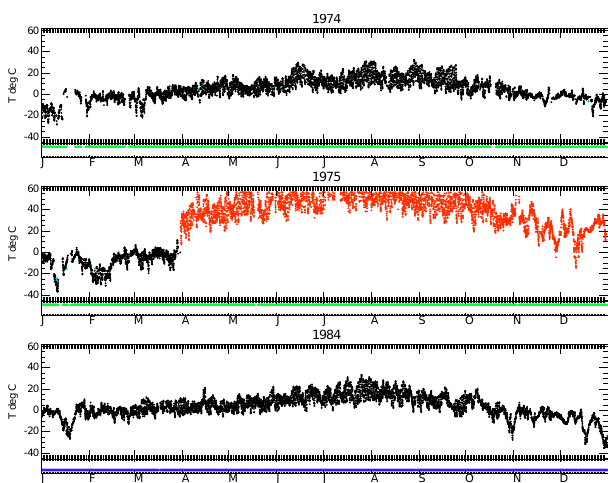
Fig. 6. Distributional gap check (test 6) example for composite station 714740-99999, Clinton, BC, Canada (51.15 ◦ N, 121.50 ◦ W, 1057m), showing temperature for the years 1974, 1975 and 1984. Red points show values removed by this test and blue points by other tests (none for the years shown). The panel below each year shows whether the data in the composited station come from the named station (blue) or a matched station (green). There is no change in source station within 1975, and so the compositing has not caused the clear offset observed therein, but the source station has changed for 1984 compared to the other two years.